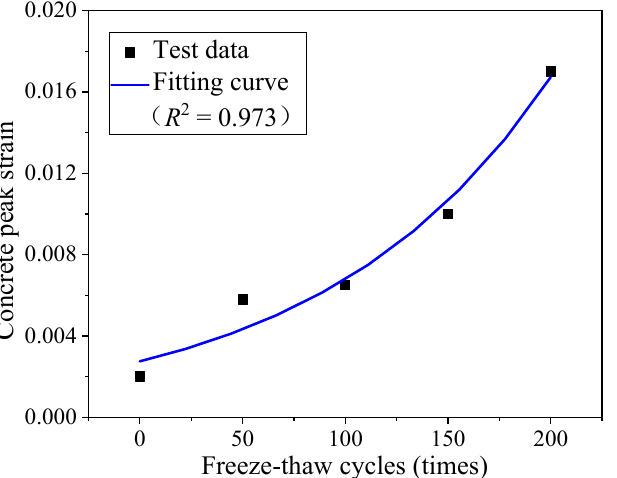
Figure 6. Fitting results for the peak strain of the concrete considering the combined action of Freeze–thaw and chloride-induced corrosion.